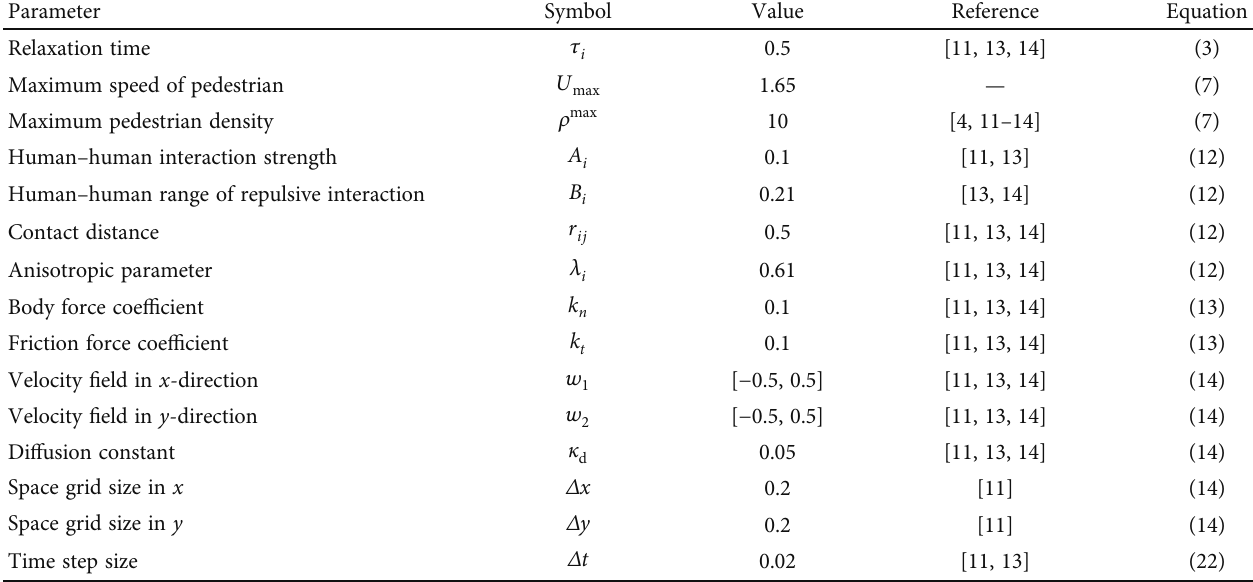
Table 1: Parameters for evacuation simulations.